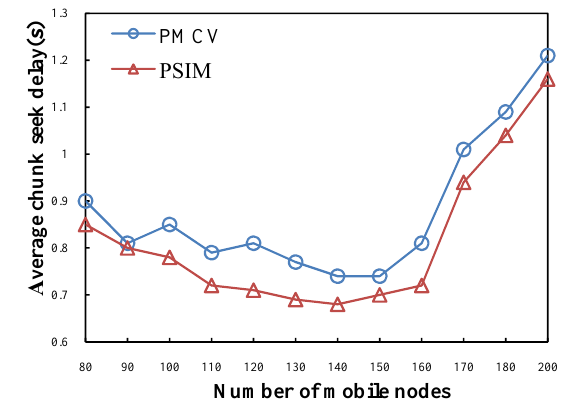
Figure 3: Average seek delay versus mobile nodes